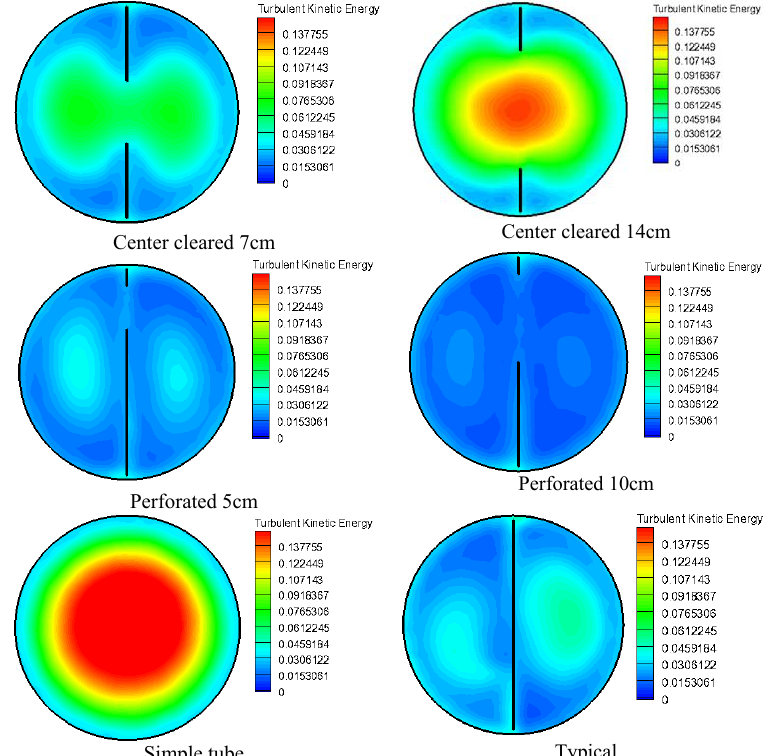
Fig. 8. Turbulent Kinetic Energy at the exit area of the tube Fig. 8 Turbulent Kinetic Energy at the exit area of the tube geometries Fig. 8 Turbulent Kinetic Energy at the exit area of the tube geometries